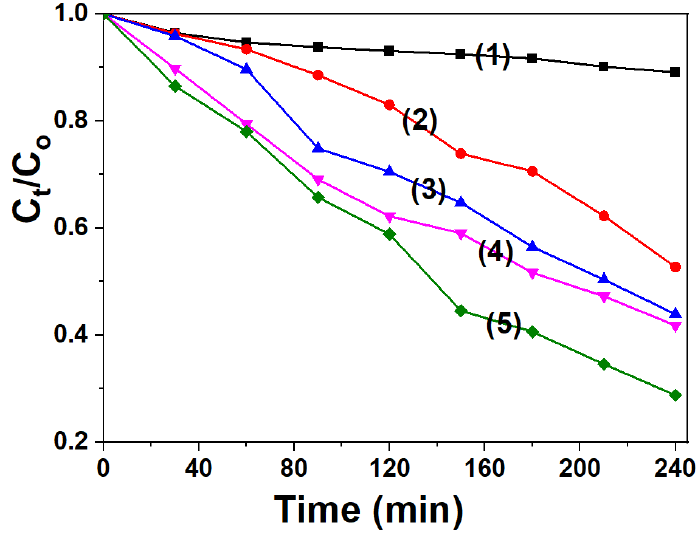
Figure 10. Effect of different catalysts on photocatalytic degradation of MB solution at different reaction times STO ( 1 ), STO/MWCNTs ( 2 ), 1% CuO/STO/MWCNTs ( 3 ), 3% CuO/STO/MWCNTs ( 4 ), 5% CuO/STO/MWCNTs ( 5 ).